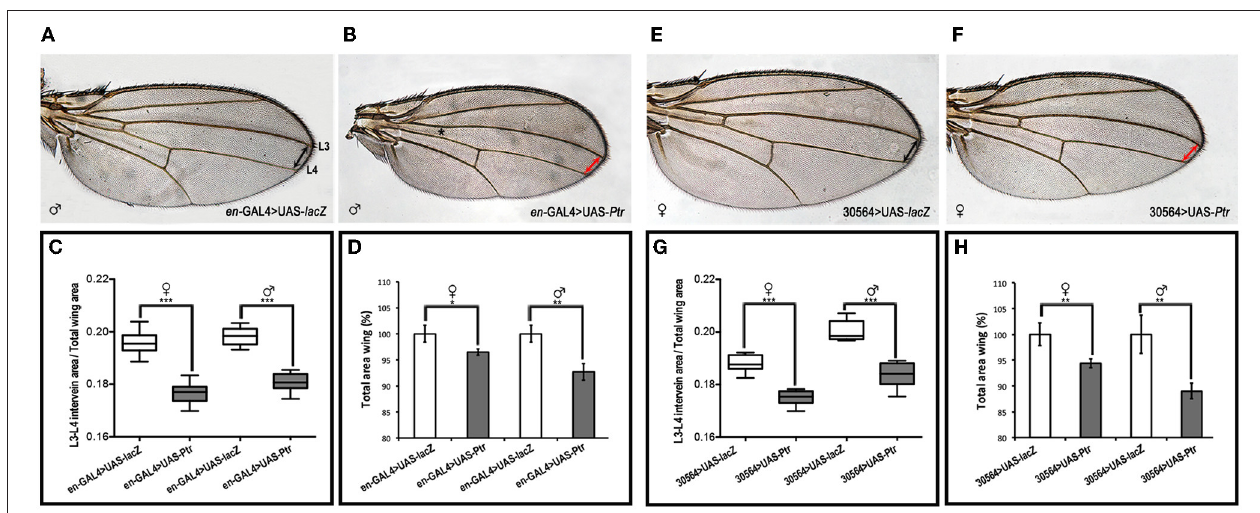
FIGURE 7 | Overexpression of Ptr reduces the Hh-signaling-active domain. Wings from male and female adult controls (A,E) and from adults expressing UAS- Ptr using two different engrailed drivers ( en -GAL4 and 30564-GAL4, respectively) (B,F) . In (A) , the longitudinal wing veins 3 and 4 (L3 and L4, respectively) are marked. In (B) , the asterisk indicates the location of the missing ACV. In control images, the distance between L3 and L4 is indicated with doubled black arrowheads, whereas, in Ptr overexpression wings, this distance is marked with doubled red arrowheads. (C,G) The ratio of the L3-L4 intervein area related to the total wing area of each genotype. (D,H) Quantification of the whole adult wing area expressed as a percentage of control wings. In all cases, control wings were obtained from en -GAL4 > UAS- lacZ and 30564-GAL4 > UAS- lacZ crosses (white boxes or columns), while the overexpression wings were obtained from en -GAL4 > UAS- Ptr and 30564-GAL4 > UAS- Ptr crosses (gray boxes or columns). In each cross, wings from female and male animals were analyzed independently. Analysis was performed using the unpaired two-tailed Student’s t -test, * p < 0.05, ** p < 0.01 and *** p < 0.001.